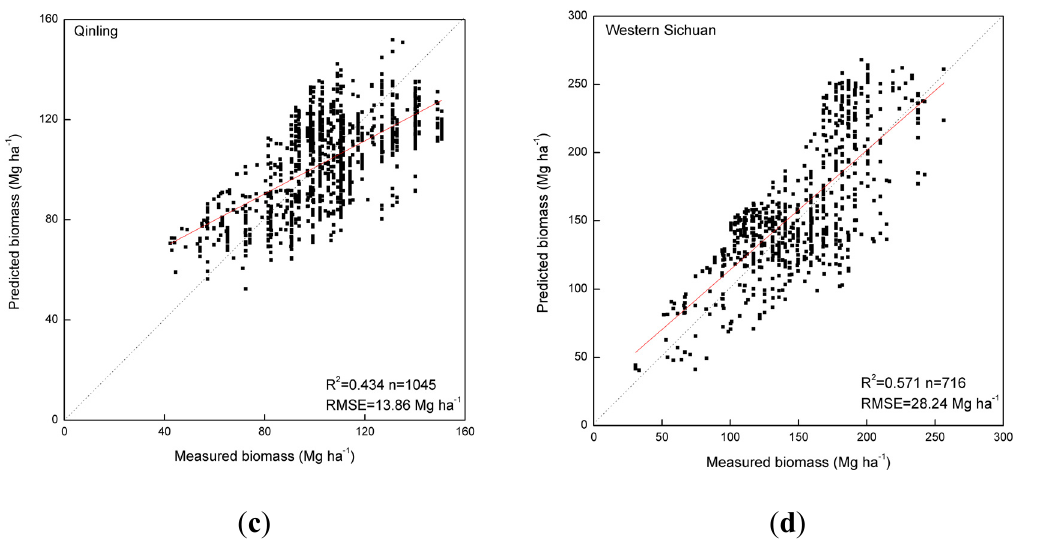
Figure 7. Comparison of forest inventory biomass (measured biomass) with GLAS- and MODIS-derived national map of AGB (predicted biomass) in four forest zones. ( a ) Tahe in